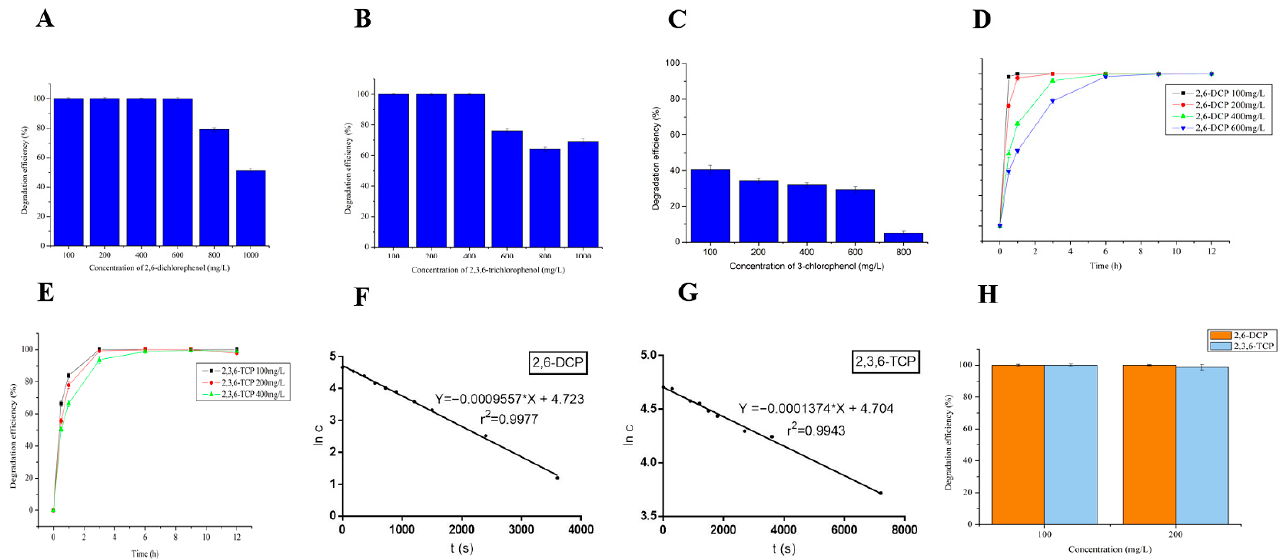
Figure 6. Degradation of chlorophenols with different structures by LAC-4. ( A ) Degradation of different concentrations of 2,6-DCP by LAC-4. ( B ) Degradation of different concentrations of 2,3,6-TCP by LAC-4. ( C ) Degradation of different concentrations of 3-CP by LAC-4. ( D ) The time-course degradation curve for the different concentrations of 2,6-DCP. ( E ) The time-course degradation curve for the different concentrations of 2,3,6-TCP. ( F ) The ln c-t curve for LAC-4 degradation of 2,6-DCP. ( G ) The ln c-t curve for LAC-4 degradation of 2,3,6-TCP. ( H ) Degradation of the 2,6-DCP and 2,3,6-TCP mixture by LAC-4. The concentration of 2,6-DCP and 2,3,6-TCP in the mixture was 100 mg/L, 200 mg/L, respectively.